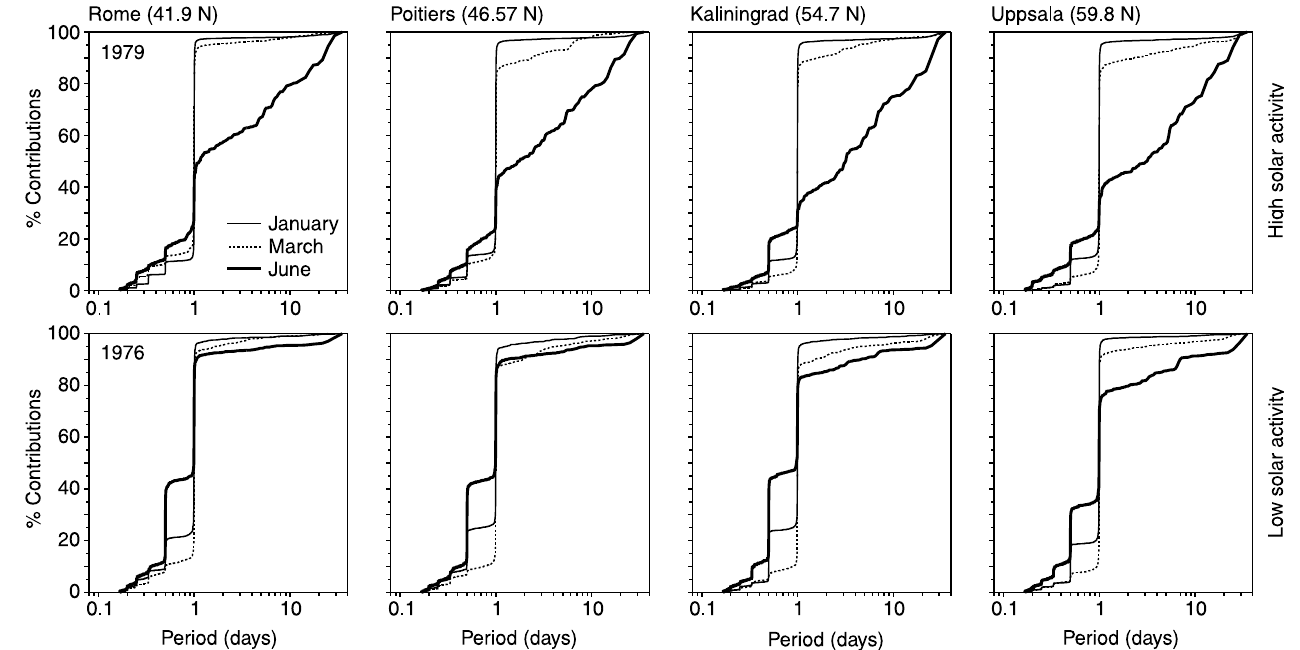
Fig. 3. Integrated percent contributions for periods lower than a given value in the periodic range from 2 h to 35 days over 2 months intervals centred for January, March and June for high solar activity (1979 – upper panel ) and for low solar activity (1976 – lower panel